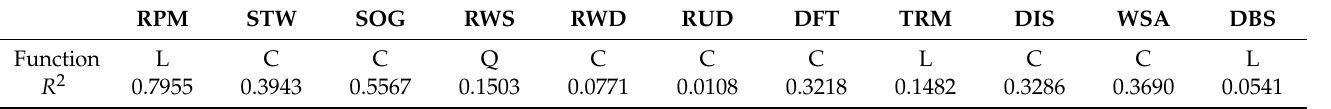
Figure 4. Curve fitting of ship parameters: ( a ) RPM, ( b ) STW, ( c ) SOG, ( d ) RWS, ( e ) RWD, ( f ) RUD, ( g ) DFT, ( h ) TRM, ( i ) DIS, ( j ) WSA, ( k ) DBS. Table 5. Results of curve fitting of input